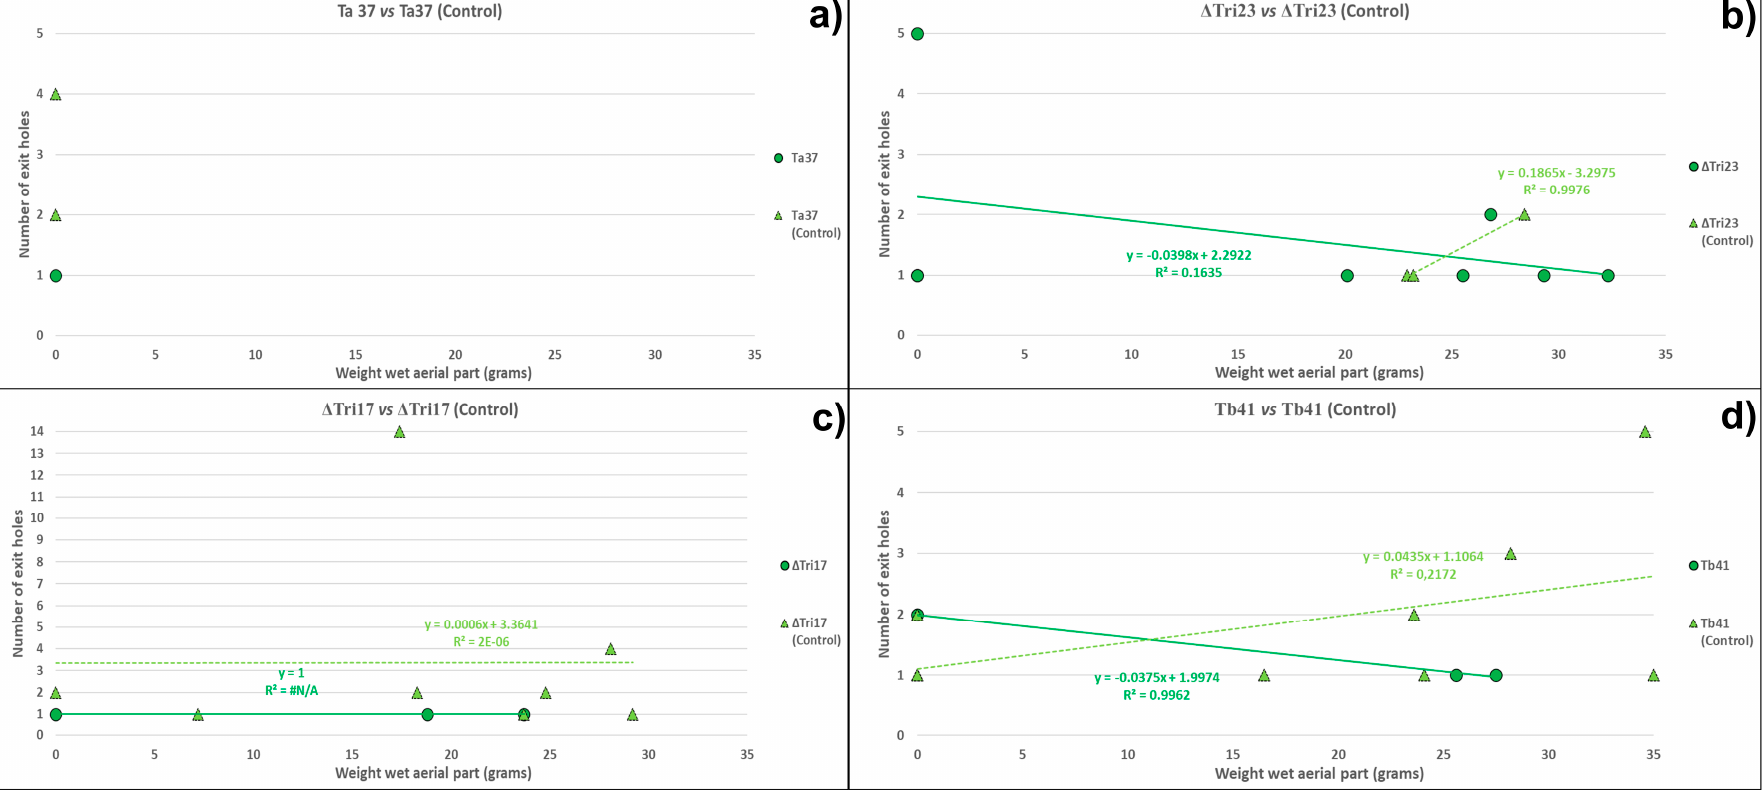
Figure 4. Linear regression of the wet weight aerial part (WWAP) of P. vulgaris plants ( x -axis) versus the number of exit holes (NEH) of P. vulgaris beans ( y -axis). “Round Intense Green Point” means bean sample sprayed with Trichoderma strains: Ta37, ( b ) ∆ tri23 , ( c ) ∆ tri17 and ( d ) Tb41. “Triangular Light Green Point” means the controls beans sample sprayed with distilled water: ( a ) Ta37 (control), ( b ) ∆ tri23 (control), ( c ) ∆ tri17 (control) and ( d ) Tb41 (control). Linear regression trendlines are coloured based on the treatment (“Continuous Intense Green Line” represents bean samples sprayed with Trichoderma strains; “Discontinuous Triangular Light Green Line” indicates bean samples sprayed with distilled